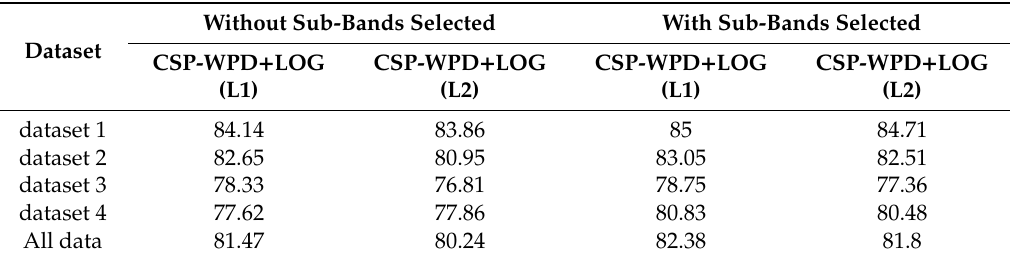
Table 14. The e ff ect of wavelet decomposition layers and sub-band selection on average classification accuracy of various datasets (the CSP-WPD